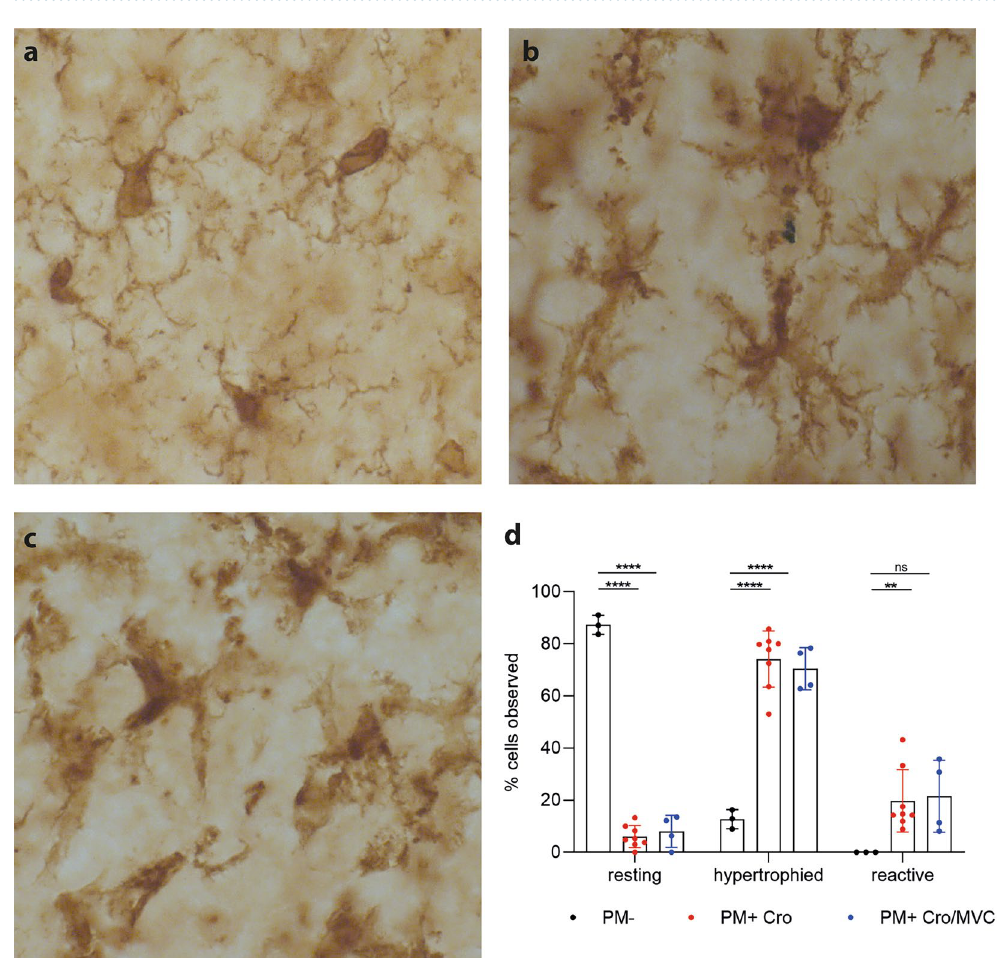
Figure 8. Microglial phenotype during acute PM. Microglial cells were classified into three categories: ( a ) resting, ( b ) intermediate/hypertrophied and ( c ) reactive. ( d ) MVC did not affect the phenotype of microglia during the acute phase of PM (PM- n = 3; PM + Cro n = 8; PM + Cro/MVC n = 4). Data are presented as mean ± SD. * p < 0.05, ** p < 0.01, *** p < 0.001, and **** p < 0.0001 (Two-way